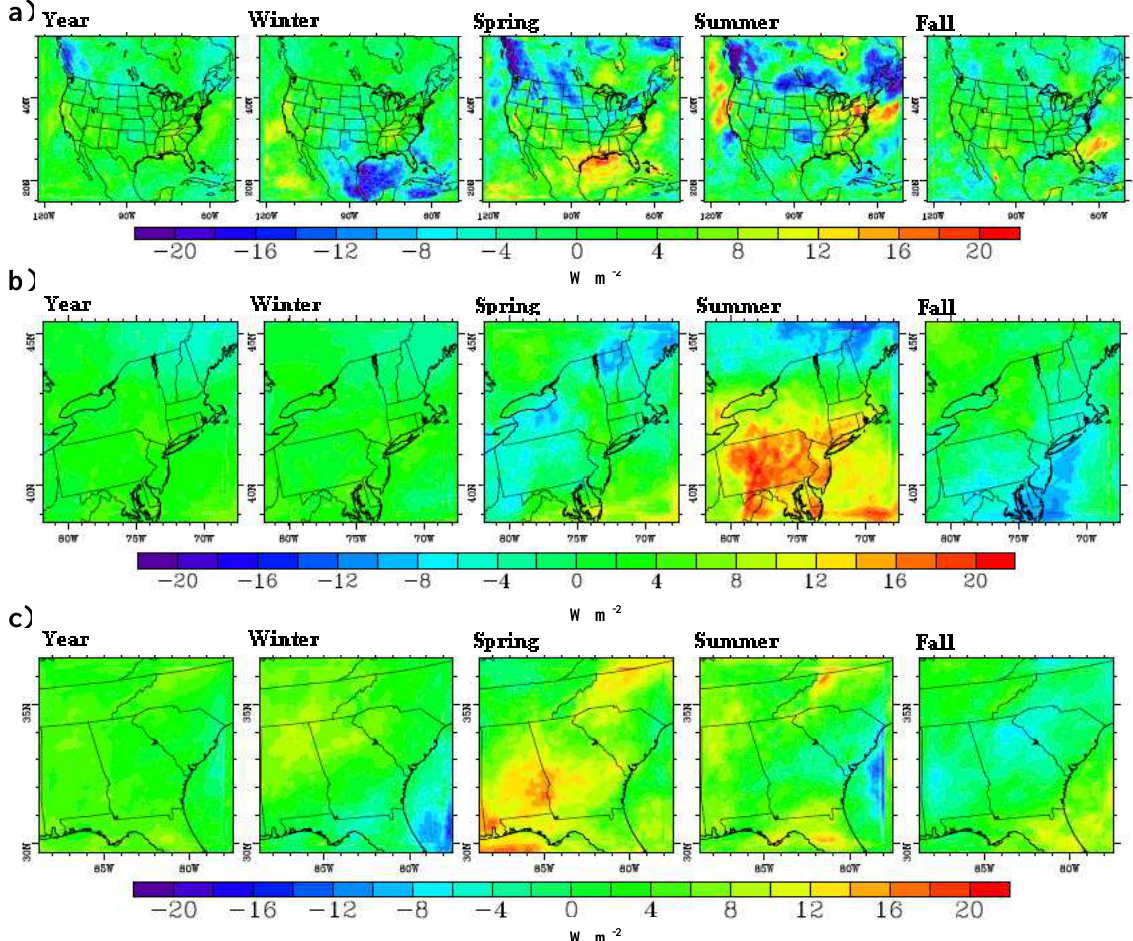
Figure 4: Predicted average yearly and seasonal downward short wave radiative flux at the 616 Fig. 4. Predicted average yearly and seasonal downward shortwave radiative flux at the surface (Wm − 2 ) change (future minus historic) for surface (W m -2 ) change (future minus historic) for (a) the 36x36 km resolution modeling 617 (a) the 36km × 36km resolution modeling domain, (b) the 12km × 12km resolution sub-domain over the Northeast and (c) the 12km × 12km resolution sub-domain over the domain, (b) the 12x12 km resolution sub-domain over Northeast and (c) the 12x12 km 618 resolution sub-domain over Southeast. 619